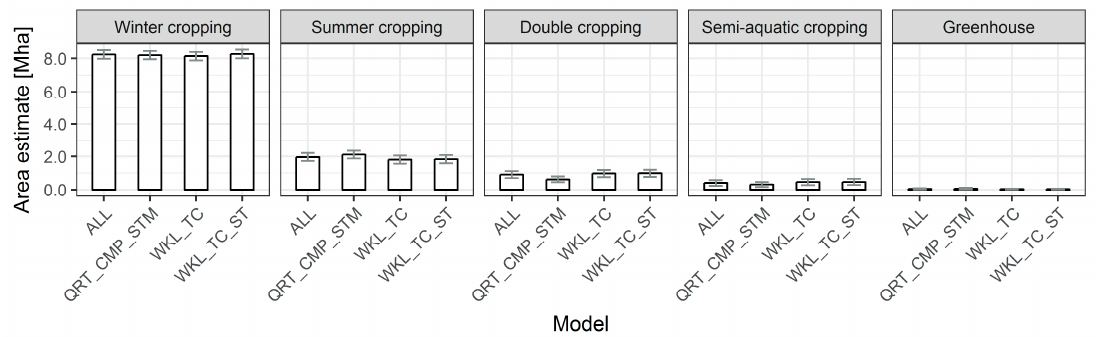
Figure 6. Error-adjusted area estimates of cropping practice classes (from left to right: winter/spring cropping, summer cropping, double cropping, semi-aquatic cropping, greenhouse cultivation) across the four best classification models (see Table 2 for abbreviations). Error bars indicate 95% confidence intervals.